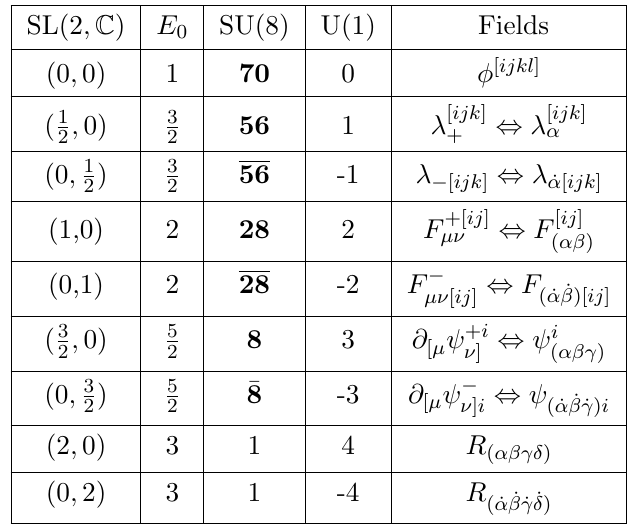
Table 1 . The (cid:12)elds of linearized N = 8 supergravity in four dimensions, which satisfy massless free (cid:12)eld equations and massless representations of Poincare group. They lift uniquely to those of the conformal group. It is a CPT self-conjugate doubleton supermultiplet of SU(2 ; 2 j 8).